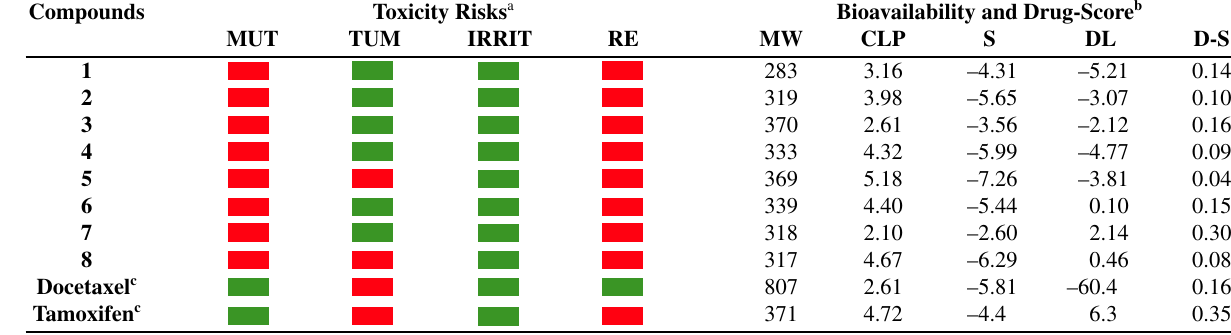
Table 6: Osiris calculations of compounds (1–8)